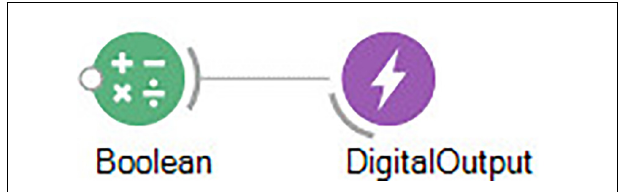
FIGURE 8 | Bonsai workflow for controlling a single Arduino digital